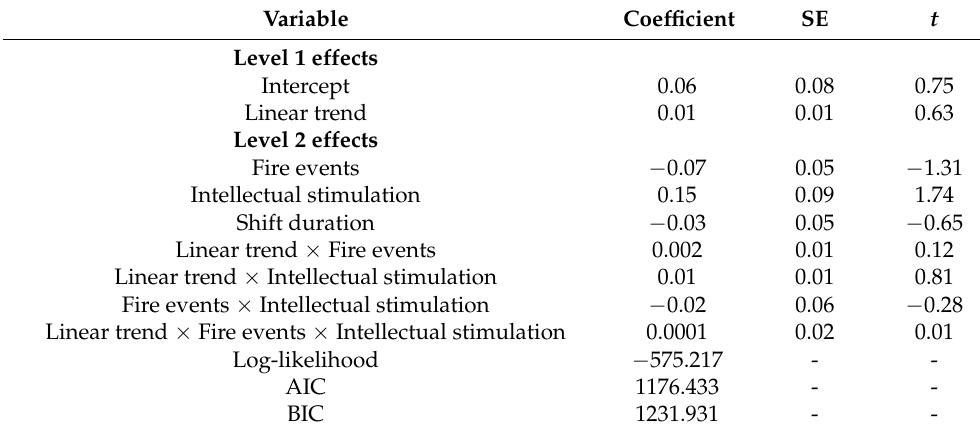
Table A5. Fire Events and Intellectual Stimulation Predicting Change in Work Engagement.